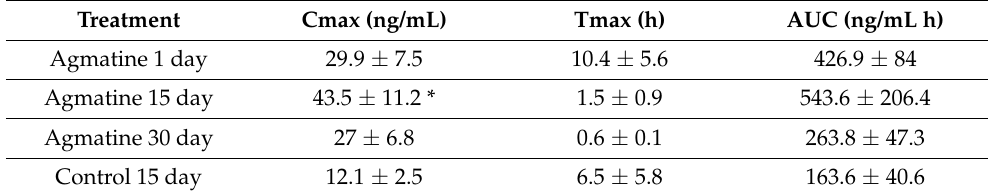
Table 11. Equine Plasma Agmatine Pharmacokinetic Parameters. The peak plasma concentration (Cmax), time to reach Cmax (Tmax), and area under the agmatine plasma concentration versus time curve (AUC) (mean ± SEM) for each treatment (agmatine 1st, 15th, 30th day; control 15th day). An asterisk indicates a significant difference from control 15th-day levels ( p < 0.05).